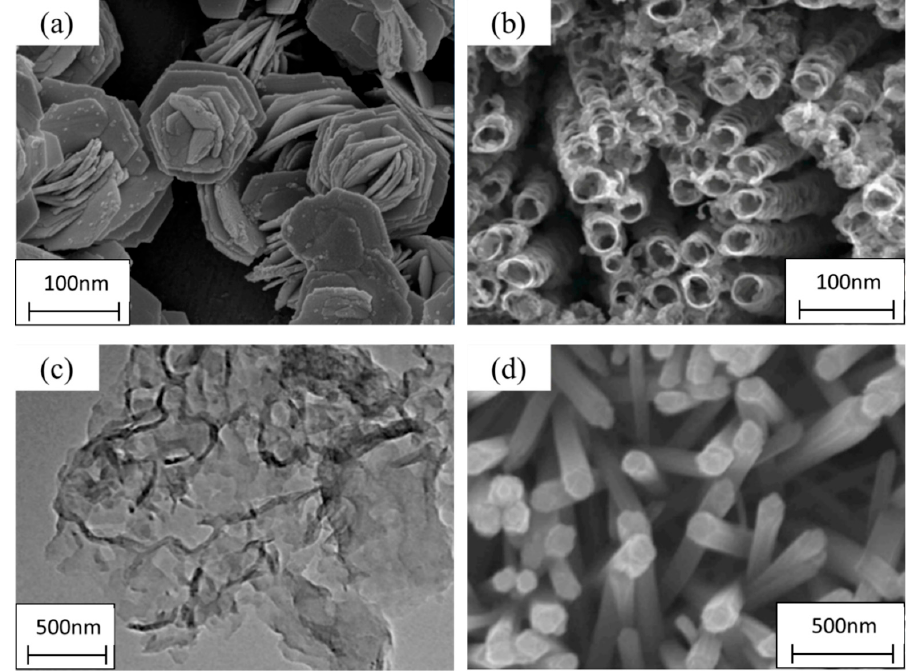
Figure 5. Examples of nanomaterial structures ( a ) nanoflowers. Adapted from [85]. ( b ) nanotubes. Adapted from [86]. ( c ) nanosheets. Adapted from [87], and ( d ) nanorods. Adapted from [88].